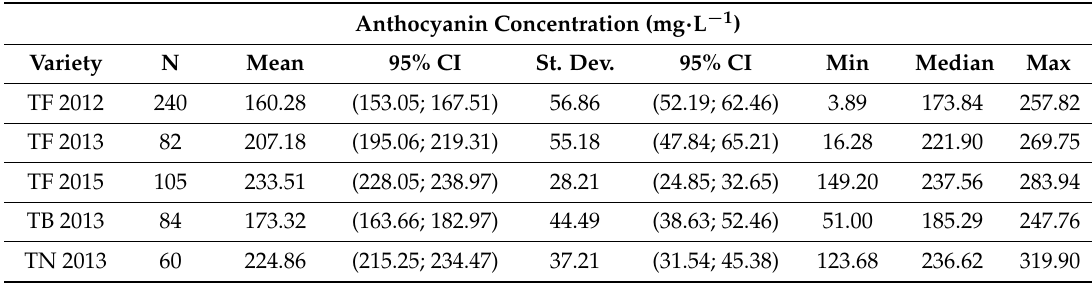
Table A1. Descriptive statistics for the anthocyanin concentration of the laboratory